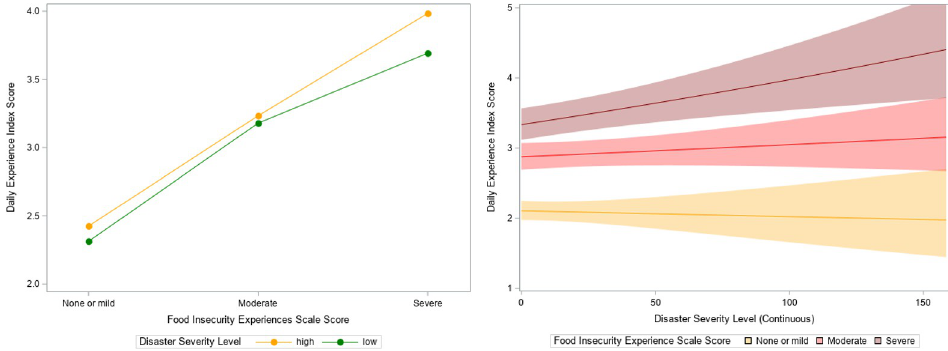
Fig 3. Interaction plots showing the marginal effect of food insecurity (Food Insecurity Experiences Scale) and disaster severity on poor mental health (Daily Experience Index score) among n = 28,292 youth from the 2017 Gallup World Poll survey. Left: disaster severity represented as a dichotomous variable a . Right: disaster severity represented as a continuous variable with 95% confidence intervals b . Notes: Adjusted for gender, urbanicity, marital status, education, employment, number of children < 15 in household, age, log annual household income, disaster severity (fixed effects), and country (random effect). a Disaster severity was measured at the country level. High disaster severity was defined as those countries in the top 10% of total number of climate-related disaster deaths per 1,000,000 population between the years of 2015–2017. Low disaster severity was defined as those countries in the bottom 90% of total number of climate-related disaster deaths per 1,000,000 population between the years of 2015–2017. b Disaster severity was measured at the country level, defined as the total number of climate-related disaster deaths per 1,000,000 population between the years of 2015–2017